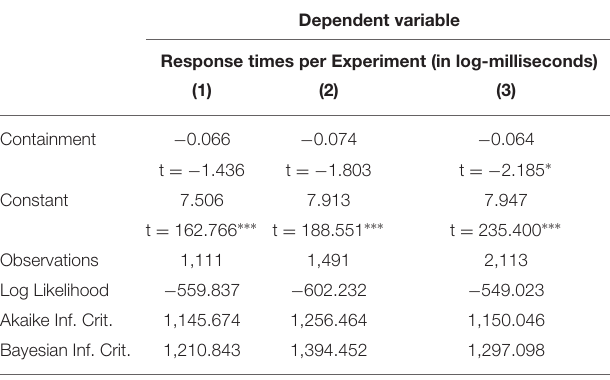
TABLE 12 | Model fitted with treatment-contrast coding for response times of Experiments 1–3.